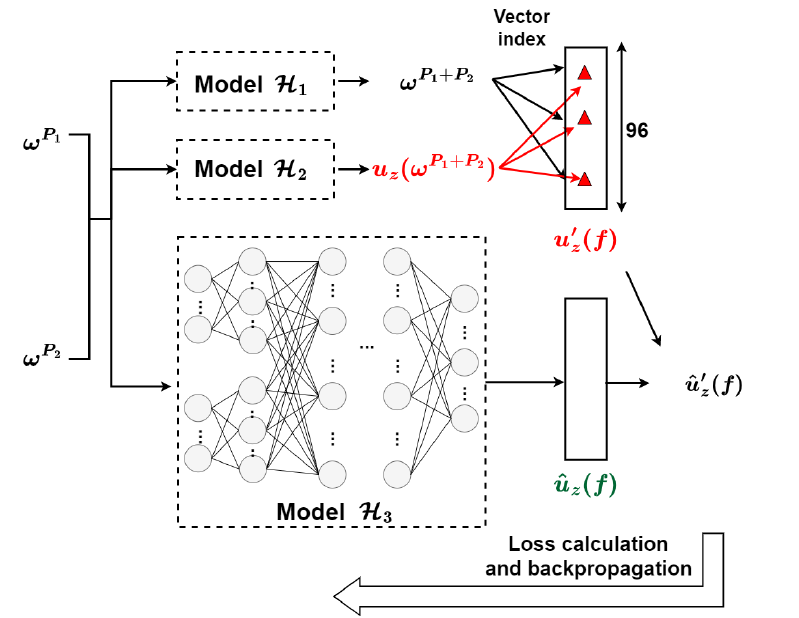
Figure 14. Graphical diagram of connected neural network structure for model H I The final model H I keeps the same structure of H 3 with three hyperparameters 3 k = 10, d = 4, D = 200 together with the integration of predictions from H 1 and H 2 . The network is trained for a maximum of 5000 epochs with a batch size of 80. The optimiza- tion algorithm is Adam with a constant learning rate of 10 − 4 , and L 2 regularization of 10 − 5 is